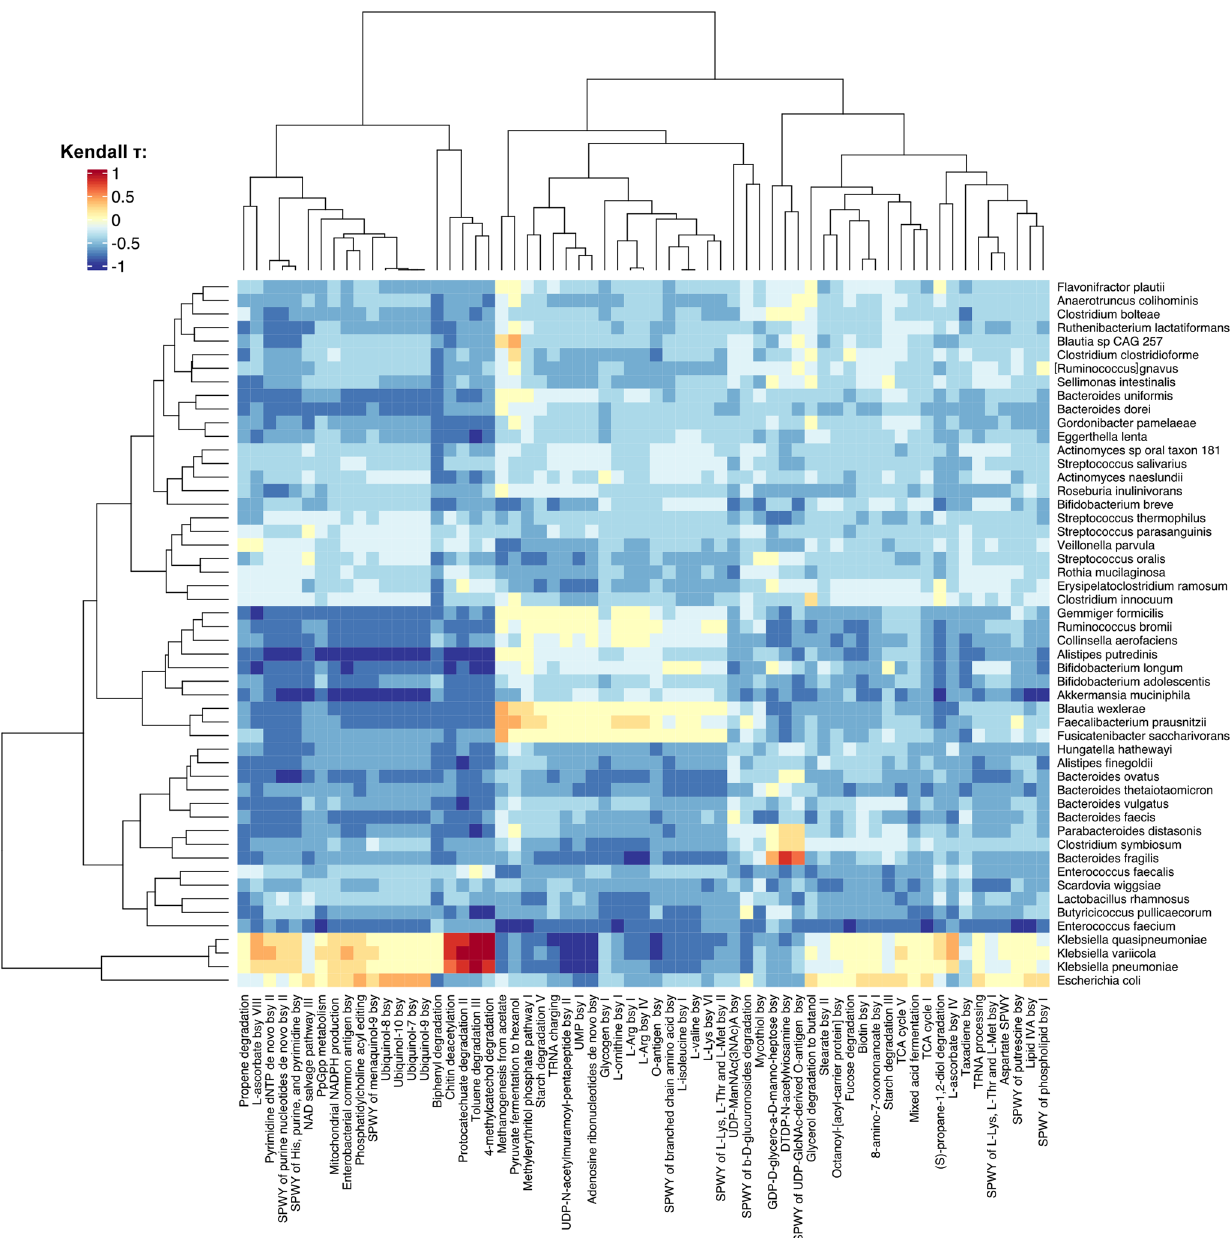
Fig. 3 Functional potential of the components of the gut microbiome networks in pediatric HSCT patients. Heatmap representing the Kendall correlation between species-level relative abundances and pathway CPMs (copies per million, see Methods) at all three timepoints. Species considered are the same used for network construction in Fig. 1. Only pathways that were differentially represented among groups ( p < 0.05, Kruskal – Wallis test, grouping samples by feeding route, LVX administration, and timepoint) were considered. Pathway names (following the MetaCyc annotation) were shortened as follows: SPWY super pathway, bsy biosynthesis. n = 90 samples from 30 ramosum . Other hubs at T2 included B. uniformis , also scored as a keystone together with B. fragilis .